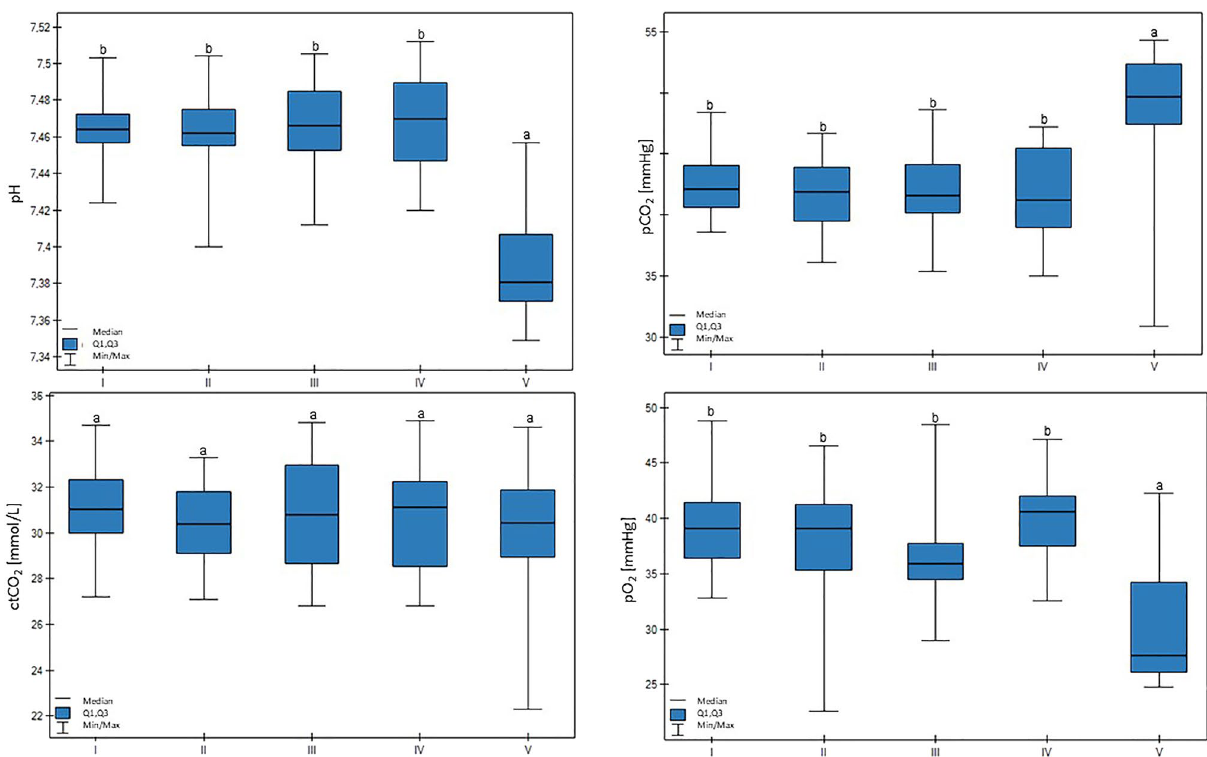
Figure 2. Differences in pH, pO 2 (partial pressure of oxygen), pCO 2 (partial pressure of carbon dioxide), and ctCO 2 (total carbon dioxide concentration) values in cows at different production levels. In the box plots, the upper whisker represents the maximum value; the upper line of the box represents Q3 (upper quartile); the center line inside the box represents the median; the lower line of the box represents Q1 (lower quartile); and the lower whisker represents the minimum value. Groups marked by letters (a–b) differ significantly, p ≤